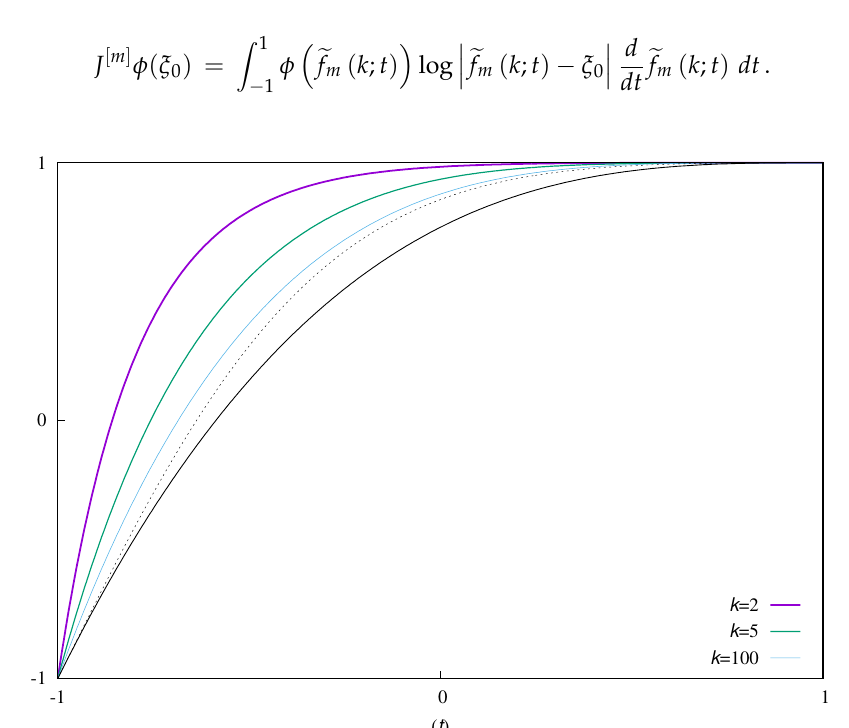
Figure 2. Graphs of the proposed rational transformations (cid:101) f 3 ( k ; t ) , k = 2, 5, 100, compared with (cid:101) γ 3 ( t ) ( t ) (: solid (: dotted line) and P Sat 3